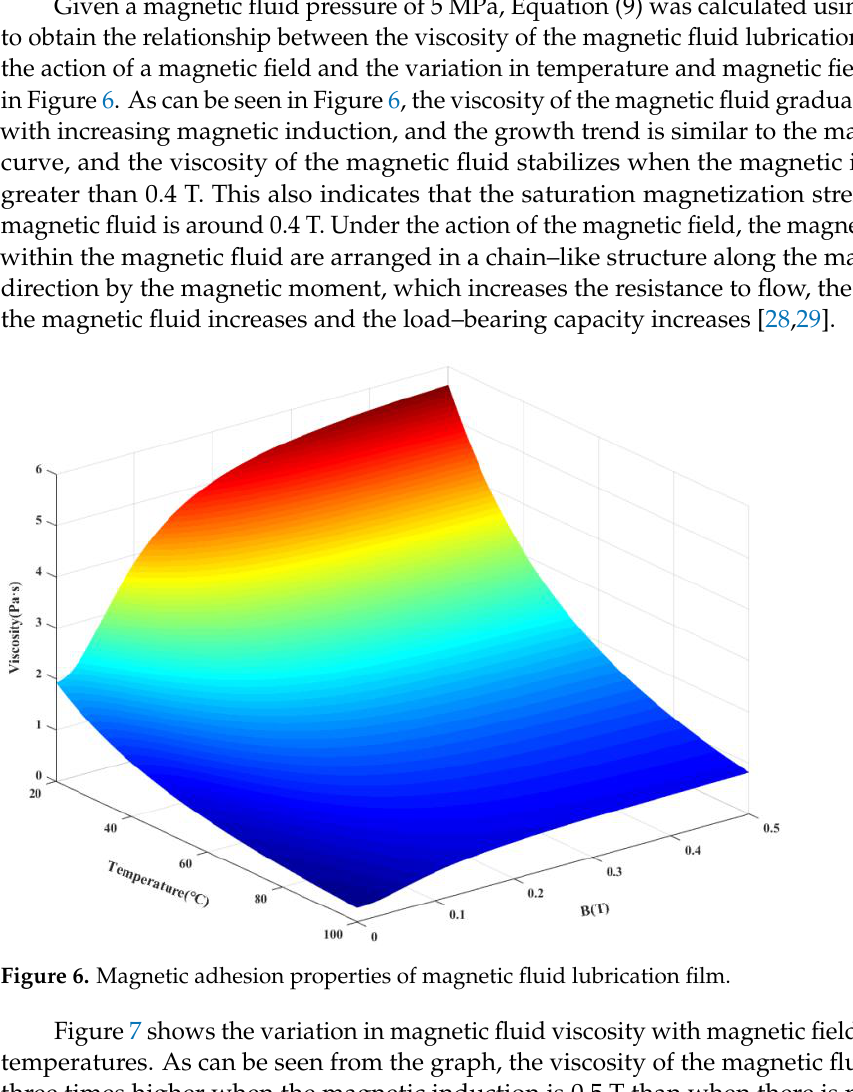
Figure 7. Viscosity relationship of magnetic fluid lubrication film under magnetic field. 3.2. Flow Field Analysis of Magneto – Fluid Lubricated Bearings Given an oil film pressure of 5 MPa in the bearing, a spindle speed of 5000 rpm, an ambient temperature of 20 °C and four different eccentricity rates (0.2, 0.4, 0.6 and 0.8), the oil film pressure and temperature distributions were calculated using Ansys software. Set the grid to Sweet and Type to Element Size. When the eccentricity is 0.8, the minimum film thickness is 0.05 mm, and to ensure that there are two or three layers of mesh at the minimum film thickness, set the Sweet Element Size to 0.02 mm. Set Element Order to Linear and Element Size to 0.05 mm. Set the maximum energy residual value to 10 −6 and the number of iteration steps to 500. The magnetic fluid as a non-Newtonian fluid, the Equation (9) is compiled into the viscosity formula of the UDF as the magnetic fluid, the magnetic field strength is set to 0.4 T. Use an eccentricity of 0.2 as an experimental example, set the Sweet Element Size to 0.015 mm and 0.01 mm as the experimental group, and then set 0.02 mm as the control group for mesh convergence experiments. Take the position of the convergence wedge 3 mm away from the minimum film thickness point as the analysis object. Let the pressure